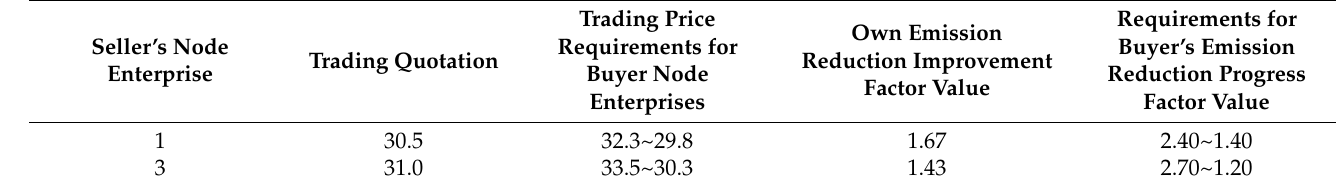
Table A6. Factor values of the seller’s node enterprise and requirements for the buyer’s node enterprise.